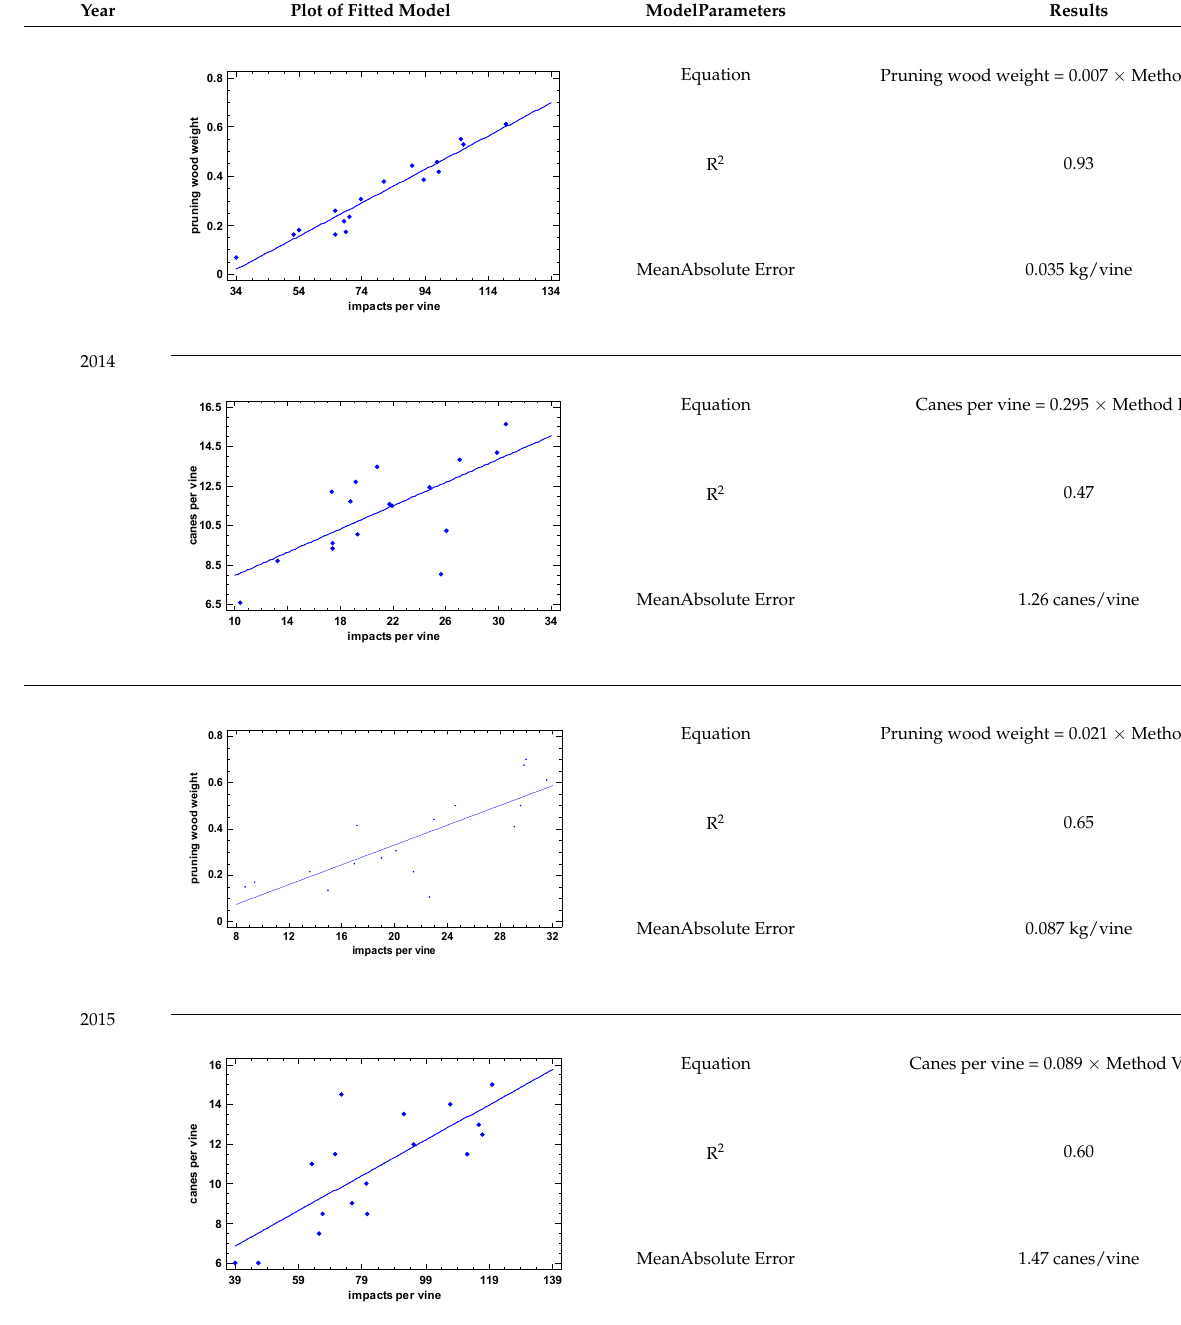
Table 7. Best fitted models for the estimation of pruning wood weight and canes per vine using a laser scanner on Syrah.